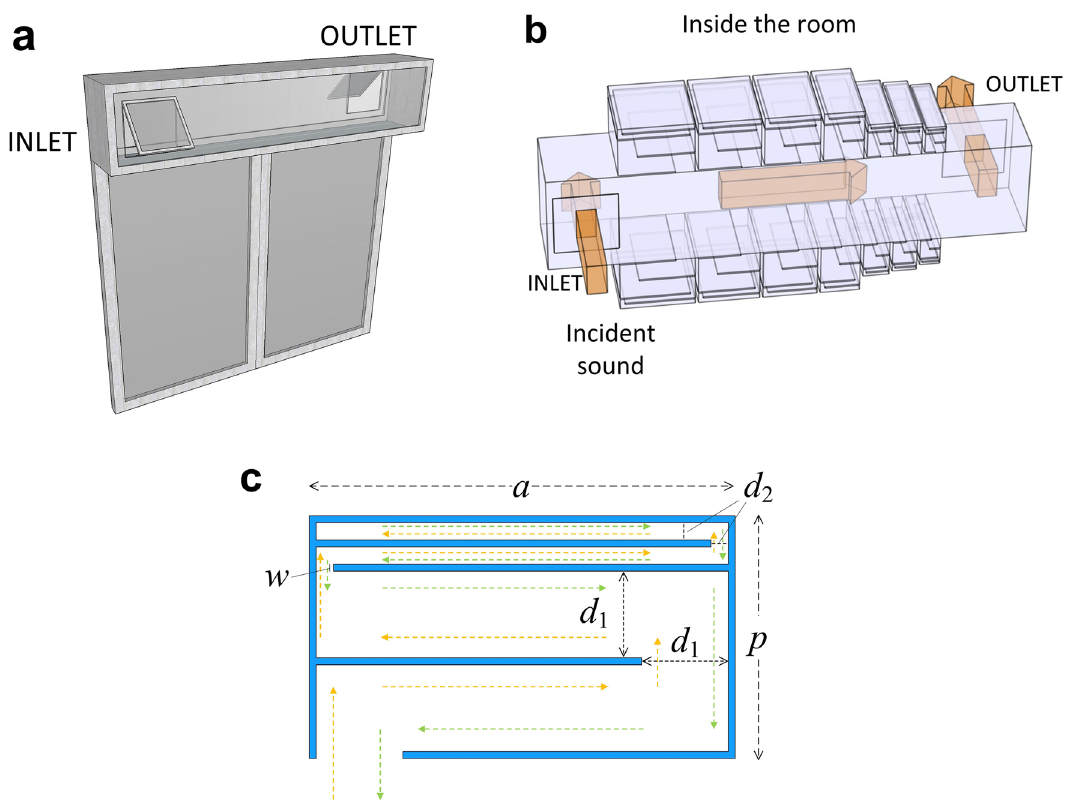
Figure 1. ( a ) A sketch of the staggered window used in practice. ( b ) The ventilation duct of the staggered window with the proposed silencers installed. ( c ) A cross-sectional sketch of each element in the proposed